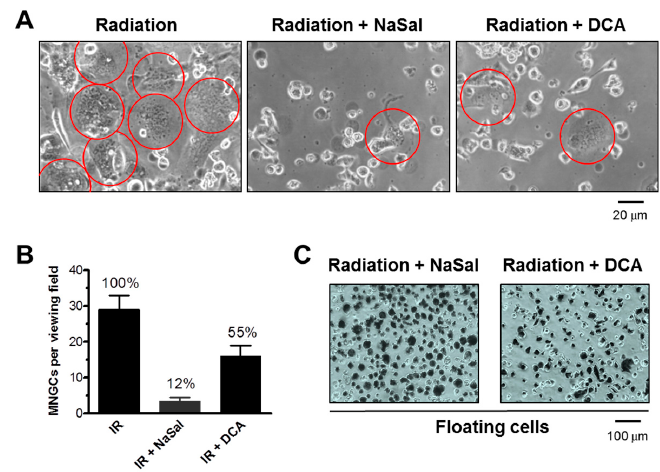
Figure 5. ( A ) Phase-contrast photomicrographs showing the effect of NaSal and DCA on the MNGCs